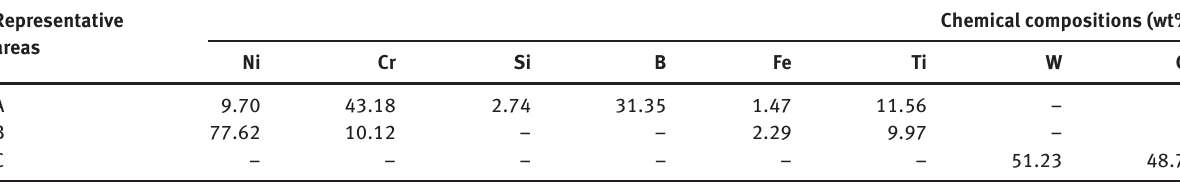
Table 5: Chemical compositions of representative areas of NiCrSiBFeTi fracture surface. Representative